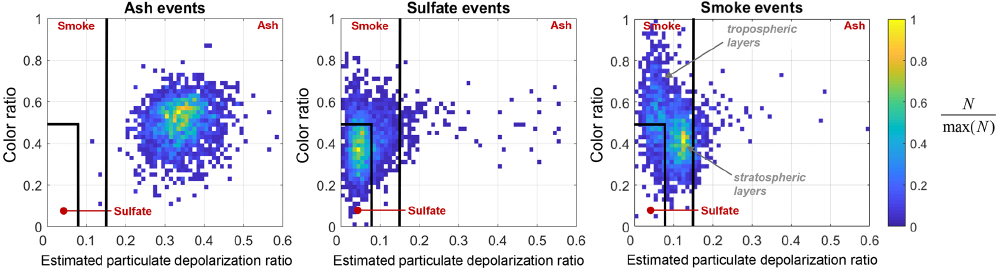
Figure 4. Joint distributions used in V4.2 development: estimated particulate depolarization ratio ( δ est p ) and feature-integrated attenuated backscatter color ratio ( χ (cid:48) ) for manually classified layers during events dominated by the aerosol type indicated in the title. Only layers with γ (cid:48) > 0 . 001sr − 1 contribute. Histograms of layer numbers ( N) are min–max normalized. Black lines indicate discrimination thresholds in 532 V4.2, and red text indicates the algorithm classification. Table 1. Manually classified events used to establish thresholds to discriminate between volcanic ash, volcanic sulfate, and smoke in V4.5. The number of unique stratospheric aerosol layers detected in V4.5 is given along with the fraction of these layers in night granules and the > 0 . 001sr − 1 contribute. The individual CALIOP granule names and the latitude–longitude– dominant aerosol type. Only layers with γ (cid:48) 532 altitude information for these layers are given in the Supplement. N